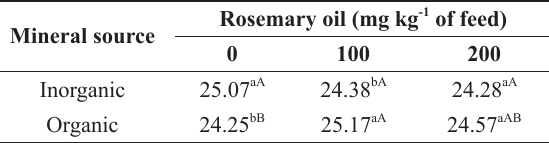
Percentage composition of yolk in eggs from laying hens fed different mineral sources and rosemary oil levels.